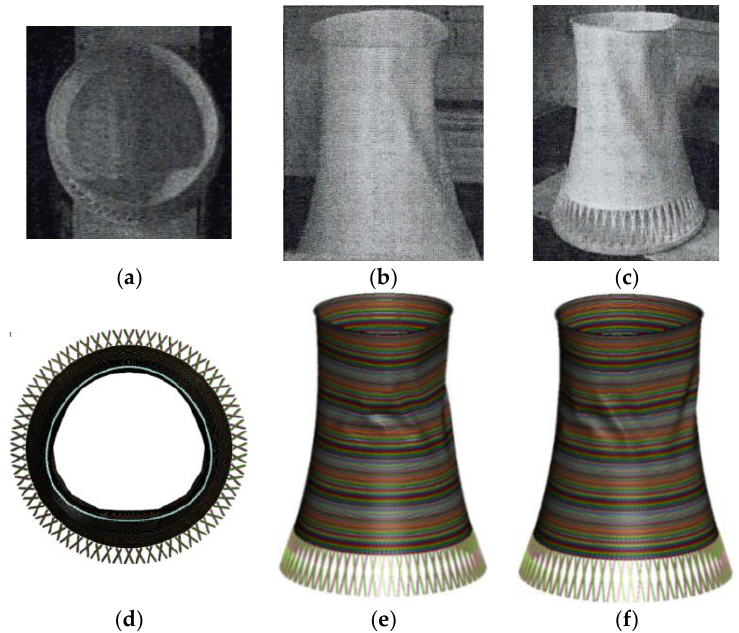
Figure 15. Comparison diagram of the wind-induced collapse of cooling towers. ( a ) Test view. ( b ) Test overall 30°. ( c ) Test overall 60°. ( d ) Simulation overhead. ( e ) Simulation overall 30°. ( f ) Simulation overall 60°.